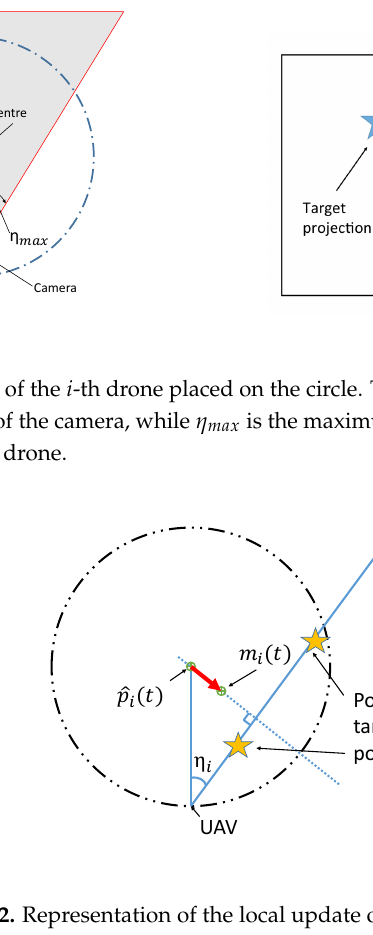
Figure 2. Representation of the local update of the